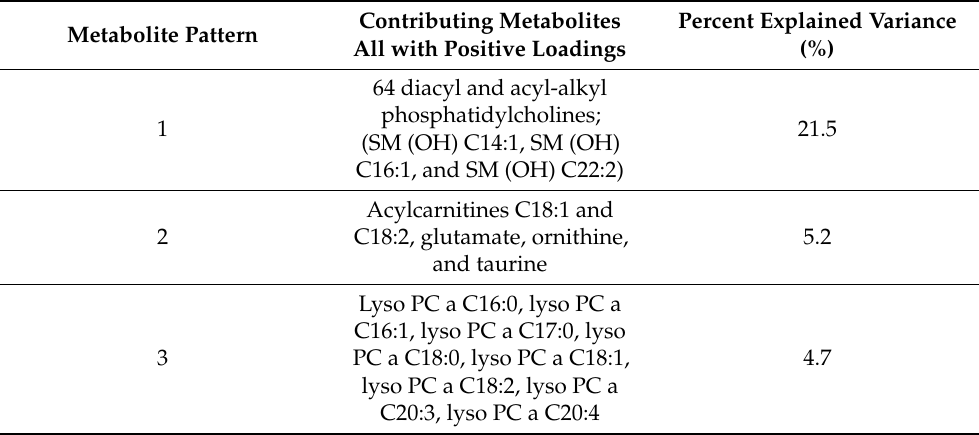
Table 2. Metabolite Patterns and their